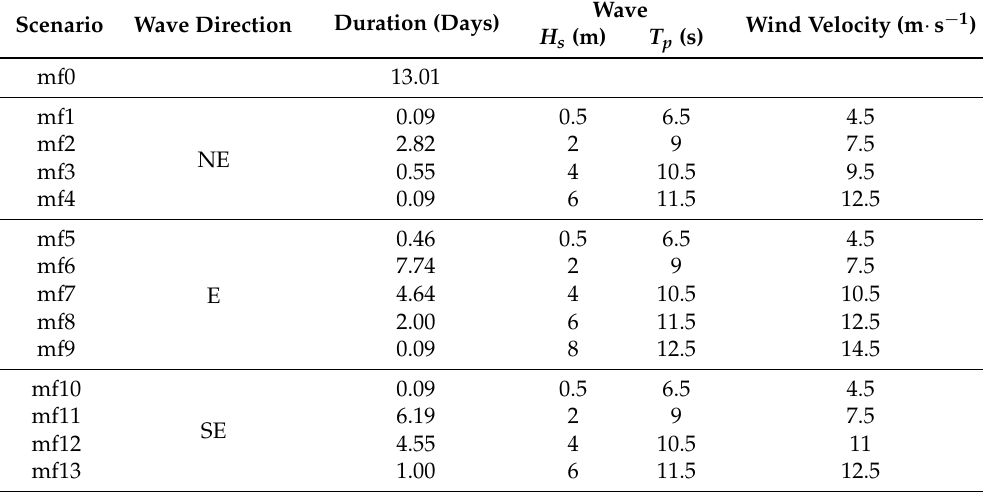
Table 2. Scenario simulations in the flood season (September to